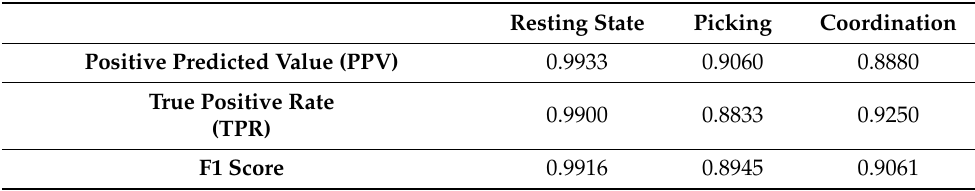
Table 5. Hierarchical classification performance